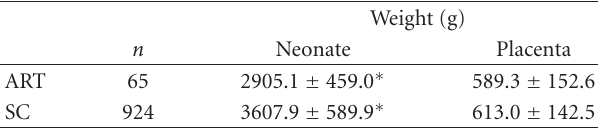
Table 3: Birth weight and placenta weight.